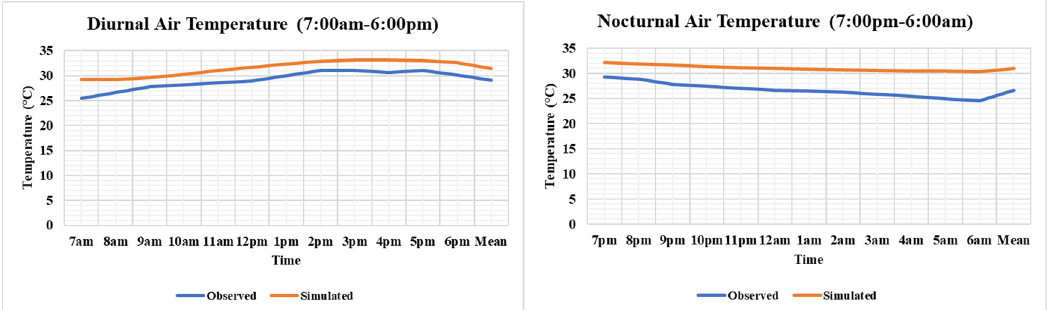
Figure 2. Measured and simulated results of diurnal and nocturnal air temperatures at FBTS.